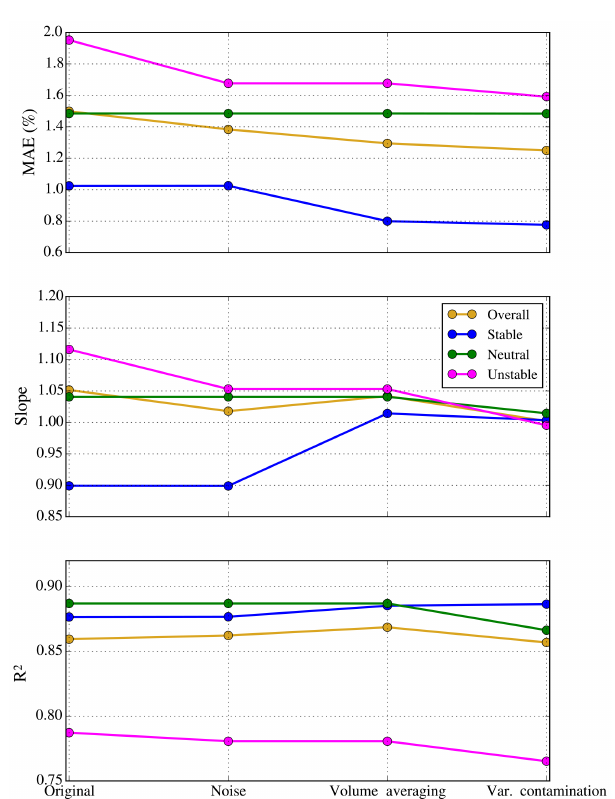
Figure 5. Progression of MAE (top), regression line slope (middle), and R 2 value of regression line (bottom) for WC vs. sonic TI at the ARM site after the application of different modules in